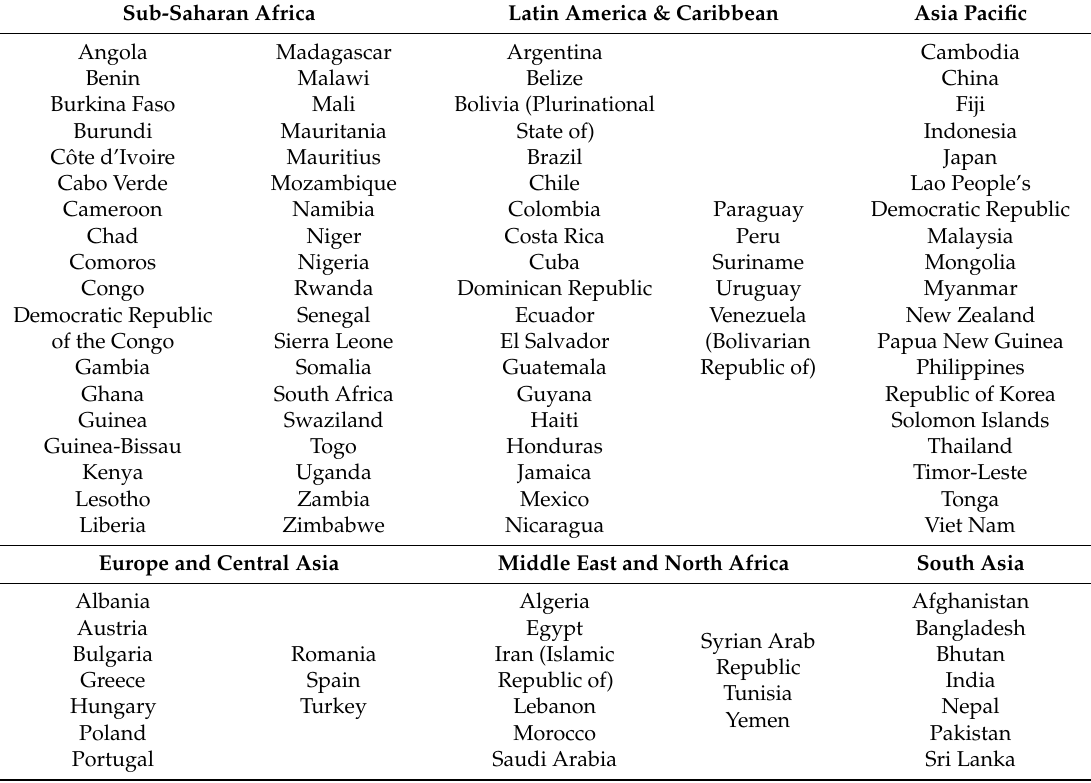
Table A1. Countries and regional groupings included in the TFP Analysis.